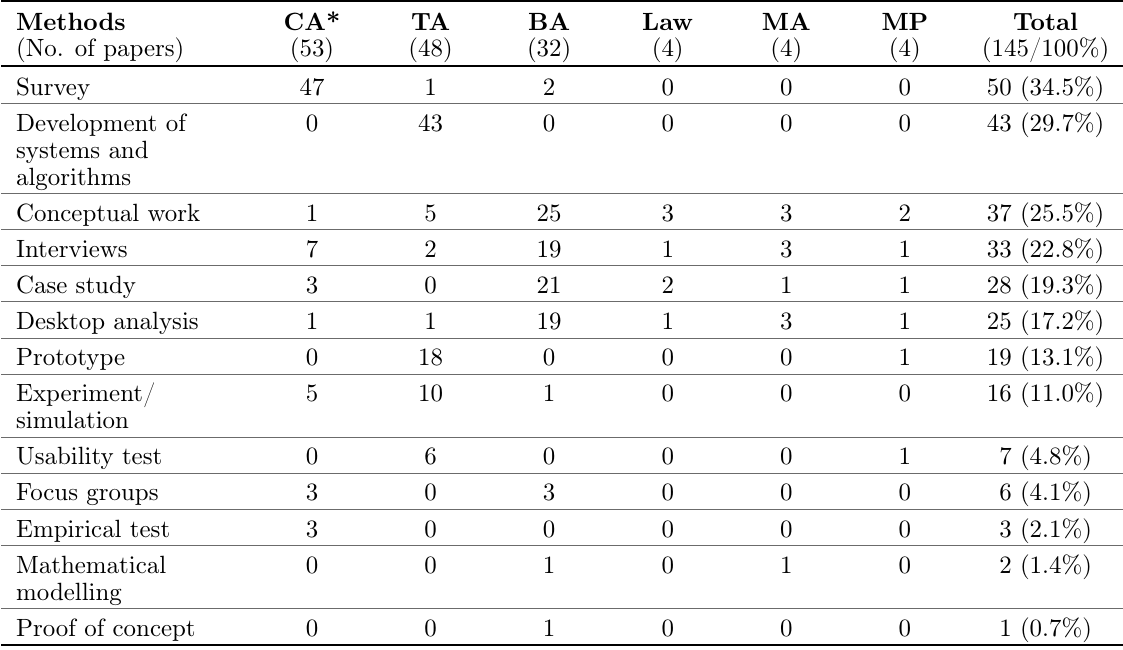
Table 10. Research methods used in mobile payments research. Methods